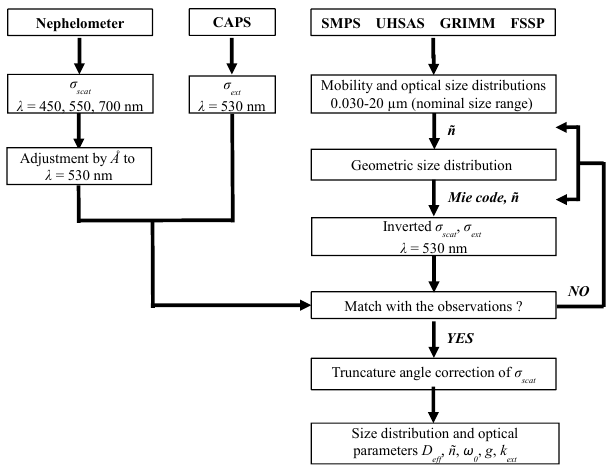
Figure 2. Data inversion procedure to retrieve the dust size distri- bution and optical